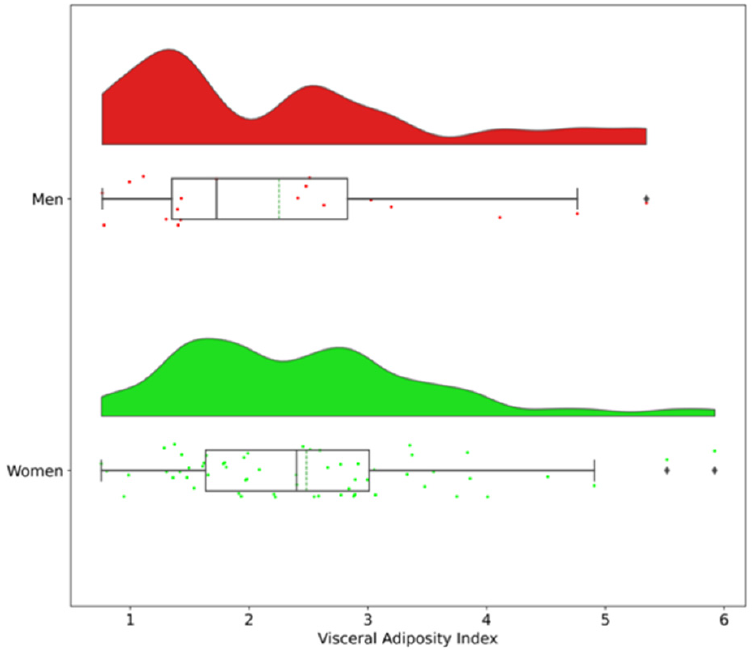
Figure 1. Representation of the distribution of visceral adiposity index (VAI) scores by sex using a raincloud plot. Median (solid line) and mean (dashed line) values are indicated in the boxplot.